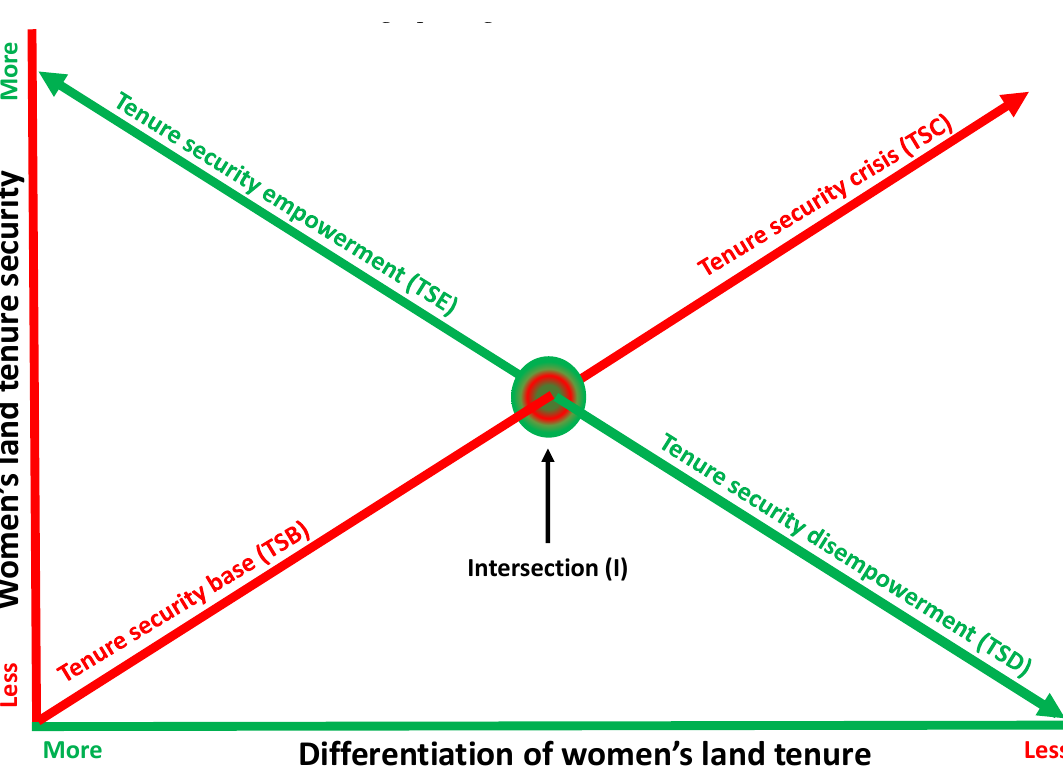
Figure 3. A women’s differentiation land tenure graph showing possible modes for actions